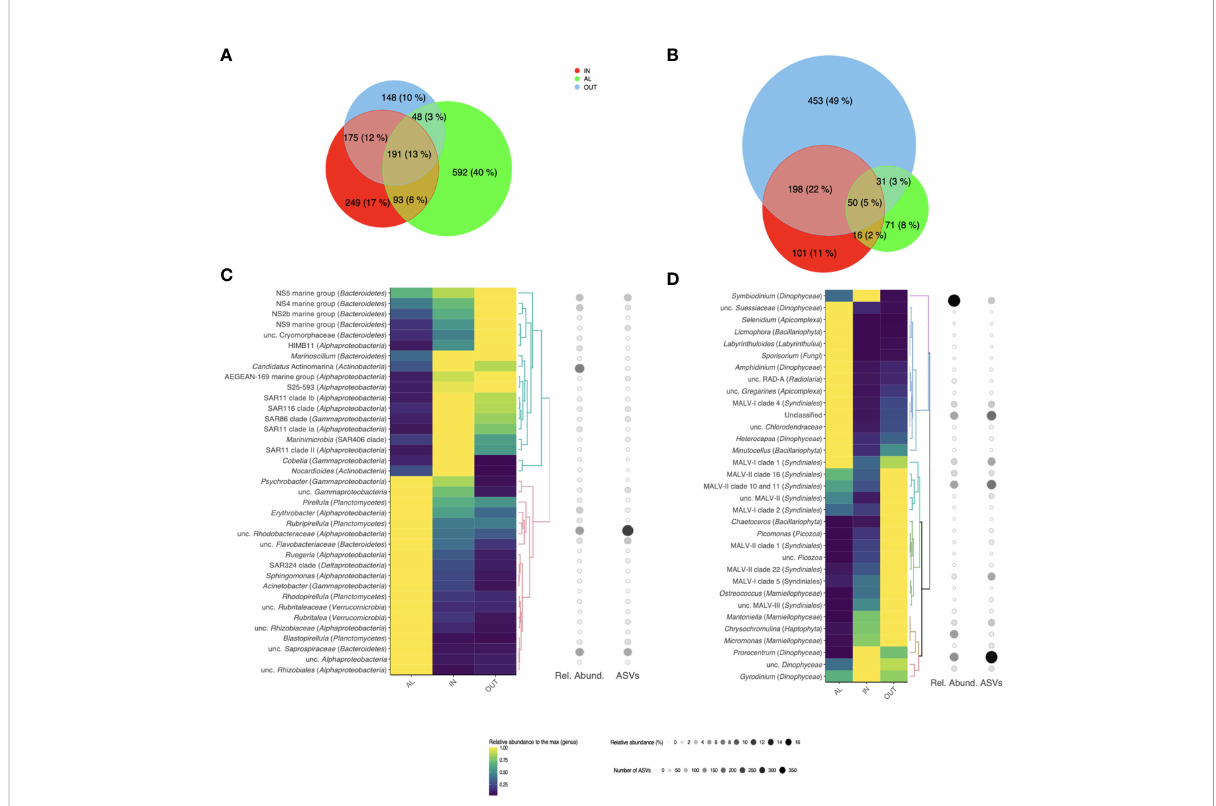
FIGURE 7 Microbial diversity and composition around an Acropora pulchra colony. Venn diagrams show the shared and unique amplicon sequencing variants (ASVs) between the heterotrophic bacterial (A) and protistan (B) communities in samples IN, AL and OUT collected on 25 April 2018 at local noon. Below the number of shared/unique ASVs, the percentages of the total richness they represent are indicated. Heatmaps display the distribution of the main bacterial (C) and protistan (D) genera in the samples. Only genera that are dominant in at least one of the three samples (representing more than 1% of the total reads in this sample) are showcased, and their relative abundances are scaled to the maximum relative abundance retrieved among the three samples. For each genus, its relative abundance (number of sequences) and richness (number of different ASVs) within the whole sequencing dataset are also